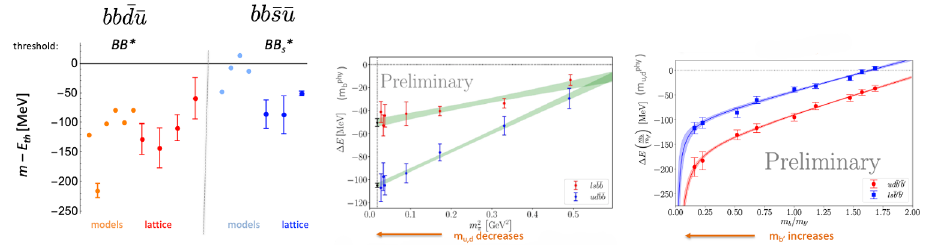
Figure 10. Left: The binding energies of bb ¯ u ¯ d with I = 0 and J P = 1 + from models [41–44] and lattice [40, 45–47]. The binding energies of bb ¯ s ¯ d with J P = 1 + from models [41, 43, 48] and lattice [40, 46, 49] are also provided (cited in order from left to right). Right: The dependence of the binding energy on m b and m u , d [39,